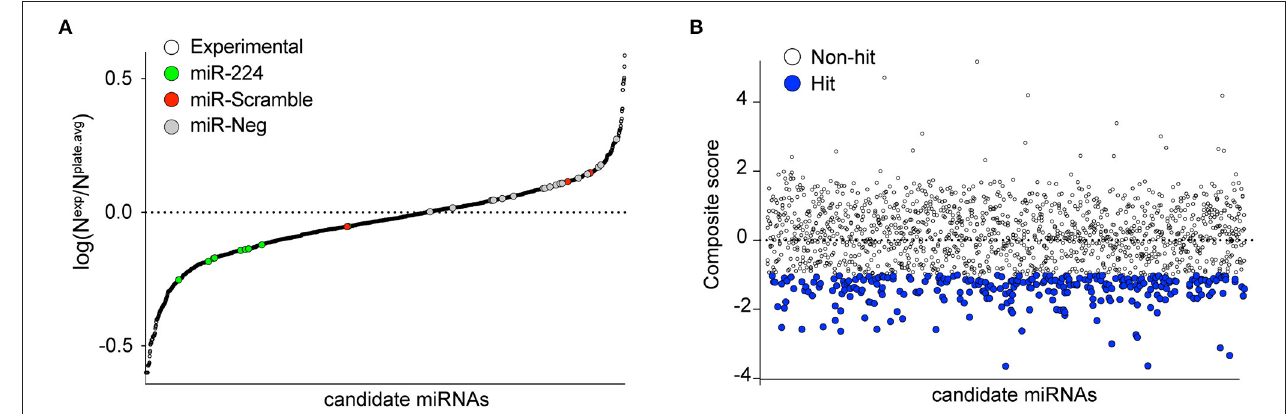
FIGURE 2 | Primary screening of human miRNAs targeting the 3 ′ -UTR of PCSK9 . (A) MiRNAs were tested for their ability to repress a luciferase reporter gene fused to the 3 ′ -UTR of human PCSK9 . Data represent average log normalized scores [log(N exp /N plate.avg )] of luciferase activity of three replicates. N exp represents firefly reporter activity normalized to renilla luciferase control per well. N plate.avg represents the average firefly reporter activity normalized to renilla luciferase control for the whole plate. Negative (miR-scramble and miR-negative) and positive (miR-224) controls are indicated by the colored dots. (B) Ranking of miRNA hits by composite score of the strictly standardized mean differences (SSMDs) of log(N exp /N plate.avg ), Z-score, and percentage of negative control (POC). MiRNAs with composite SSMD scores of < -1 were identified as positive hits (blue) in the